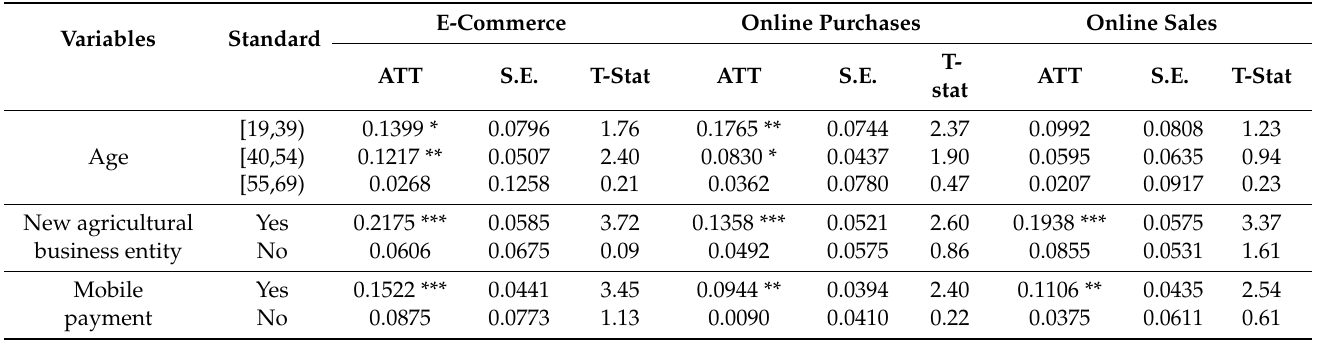
Table 6. The heterogeneity analysis involving the effect of credit on e-commerce utilization. Variables